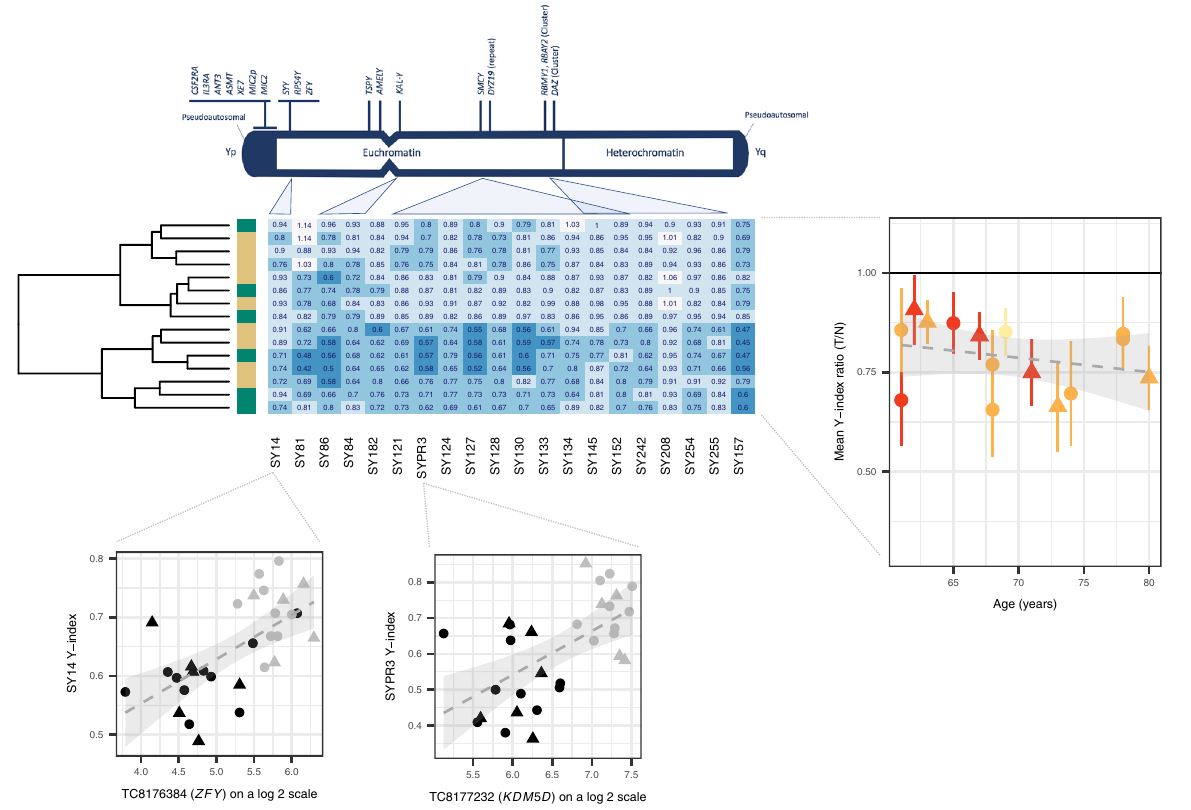
Figure 2. Validation of Loss of Y. Figure is headed with a cartoon adapted from the Promega technical manual depicting sites on chromosome Y interrogated through PCR. A heatmap details the ratios between tumour (T) and histologically normal (N) amplification signals on a patient-by-patient basis. Histology is shown as a y axis sidebar (LUAD = beige, LUSC = green). The grand mean and standard deviation of these ratios across all sites is plotted against age as expressed in years and coloured by smoking history (never smoker = yellow, ex-smoker = orange, current smoker = red). A hatched linear smooth line is shown with its 95% confidence intervals shaded in grey. The relationship between amplification signal (the Y-index, presented on the y axis) and the expression of genes in the same region (presented on the x axis) are shown below, with individual points coloured by tissue class (tumour = black, histologically normal = grey) and including a hatched linear smooth line with 95% confidence intervals shaded in grey. Tumour histology is denoted by point shape (LUAD = circle, LUSC =